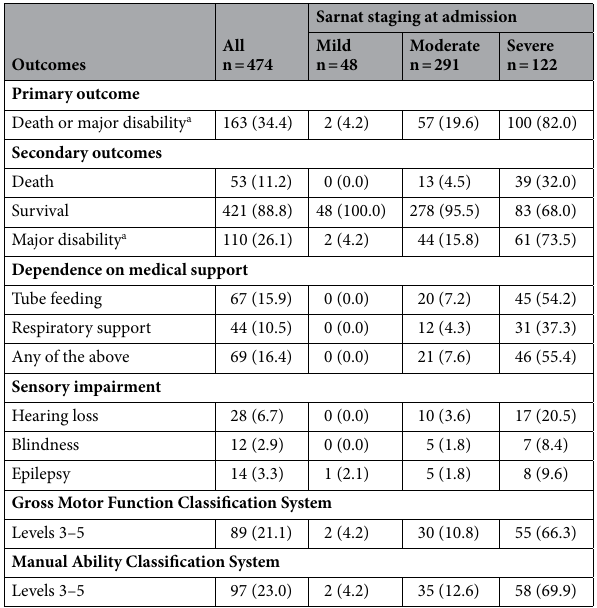
Table 2. Outcomes of cooled infants at 3 years of age. Values are shown as the number (%). Percentages are based on the number of infants for whom data were available. a Defined as survival with at least one of the following conditions: requirement for tube feeding or respiratory support, hearing loss, blindness, epilepsy, Gross Motor Function Classification System and Manual Ability Classification System scores >